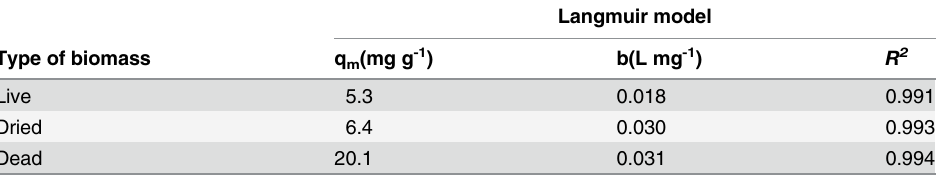
Table 2. Adsorption isotherm parameters for Ni (II) ions using live, dried and dead biomass of H . lixii .